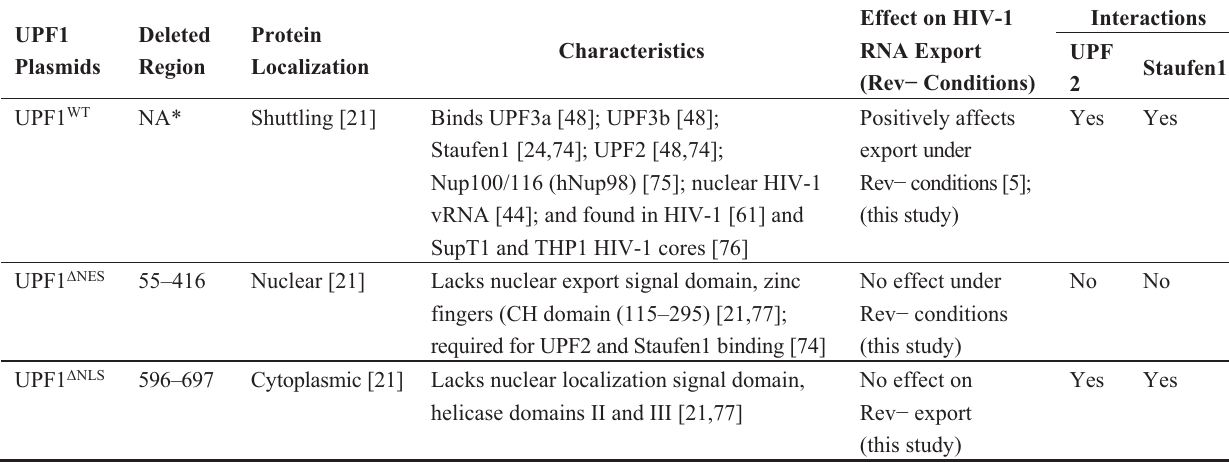
Table 1. UPF1 plasmids cited in this